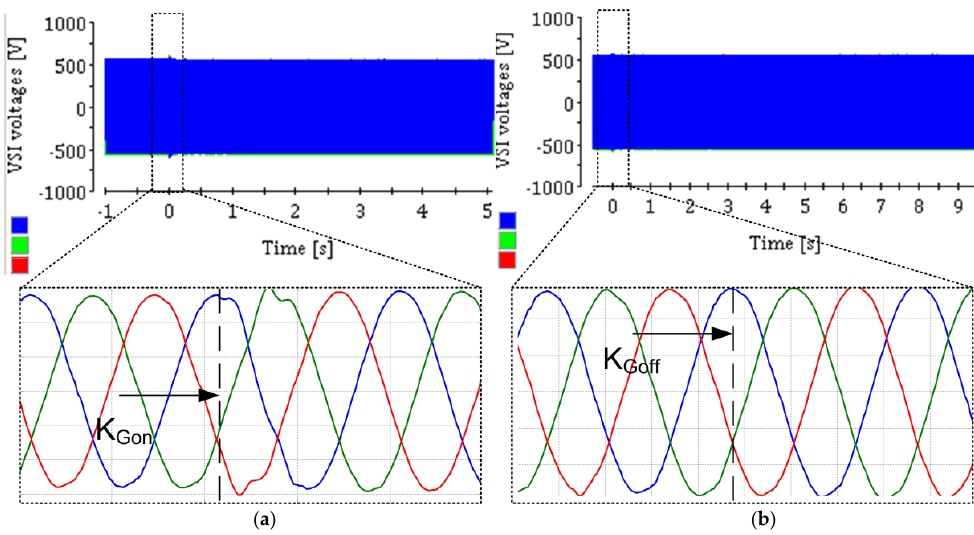
Figure 8. Transfer from autonomous to MG mode ( a ) and from MG mode to autonomous mode ( b ).